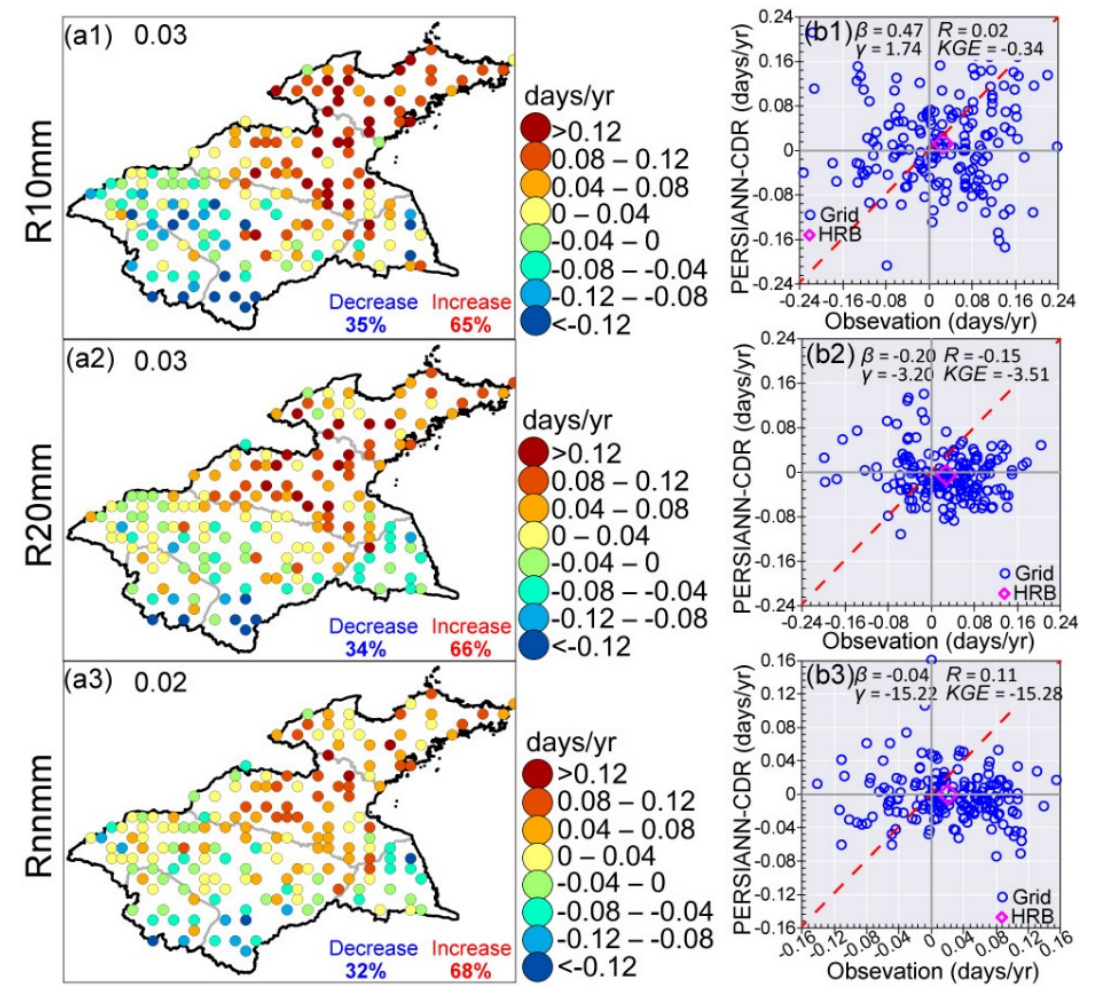
Figure 10. Spatial patterns of the temporal trends of the observational frequency-based indices and the scatterplots between observation and PERSIANN-CDR. a1 – a3 ( b1 – b3 ) are for R10mm, R20mm, and Rnnmm, respectively. In a1 – a3 , the black numbers represent the HRB trends of the observational frequency-based indices, while the blue (red) numbers indicate grid percentages with increasing (decreasing) trend across the HRB. The red dashed line in b1 – b3 is the 1:1 line.